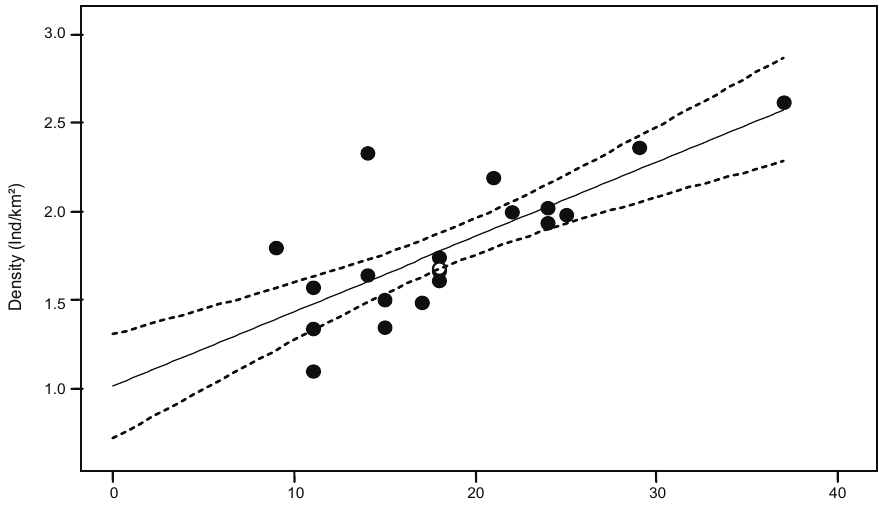
Fig. 3. The relationship between group size and population density. The best-fit regression line (Density = 0.042Size + 0.756) is provided together with its 95 % confidence limits (dashed lines). The study troop is indicated by an open